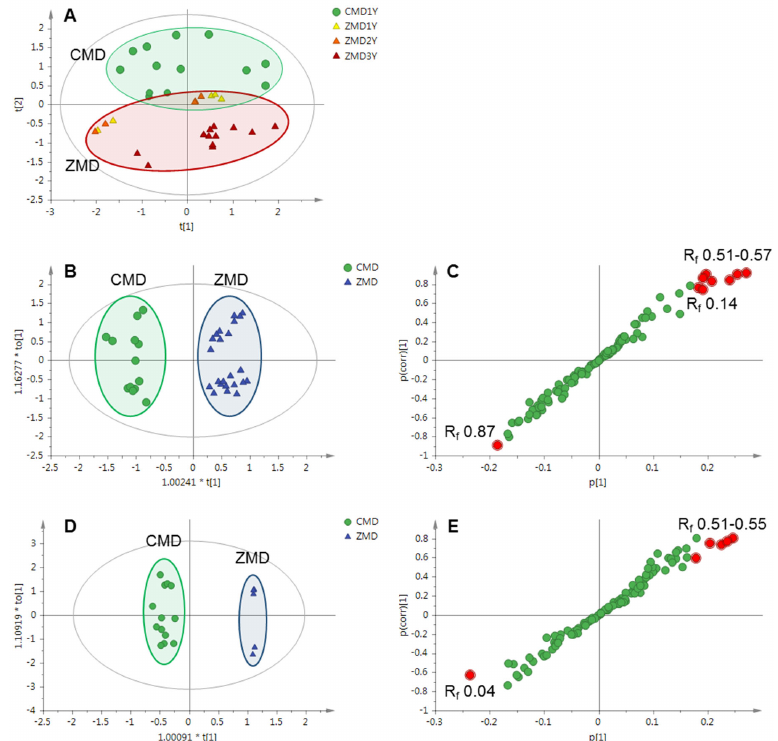
Figure 3. Multivariate analysis based on the HPTLC profiles of CMD and ZMD. ( A ) PCA score plot of CMD and ZMD (R 2 X = 0.902, Q 2 = 0.716), ( B ) OPLS ‐ DA score plot of CMD and ZMD (R 2 X = 0.621, R 2 Y = 0.945, Q 2 = 0.906), ( C ) OPLS ‐ DA S ‐ plot of CMD and ZMD, ( D ) OPLS ‐ DA score plot of one ‐ year ‐ old CMD and ZMD (R 2 X = 0.772, R 2 Y = 0.983, Q 2 = 0.917), ( E ) OPLS ‐ DA S ‐ plot of one ‐ year ‐ old CMD and ZMD. The variables with VIP > 1.5 in the S ‐ plots were highlighted with red filled circles. Then, the samples with different growth years were clustered into three groups by OPLS using the growth years as Y ‐ variables (Figure 4A). The band of R f 0.46 was found to be the characteristic component in younger samples while the bands of R f 0.13–0.14 and